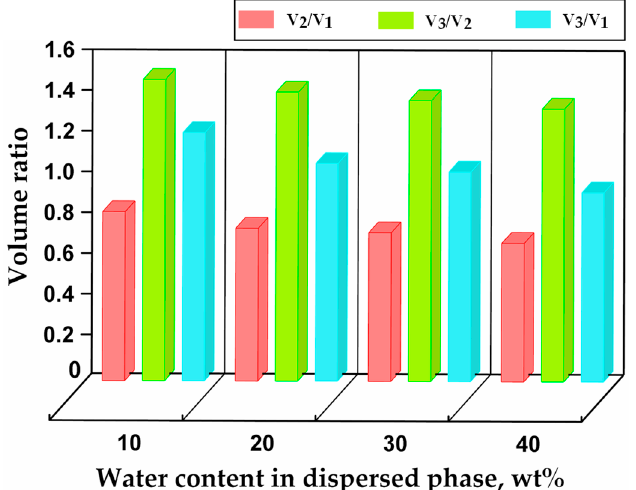
Figure 9. Relative changes in droplet/particle volume after polymerisation and swelling as a function of the initial water content in the dispersed phase. V 1 is the volume of droplets in silicone oil, V 2 the volume of cured particles in silicone oil, and V 3 the volume of swollen particles in deionised water after swelling to the equilibrium state.